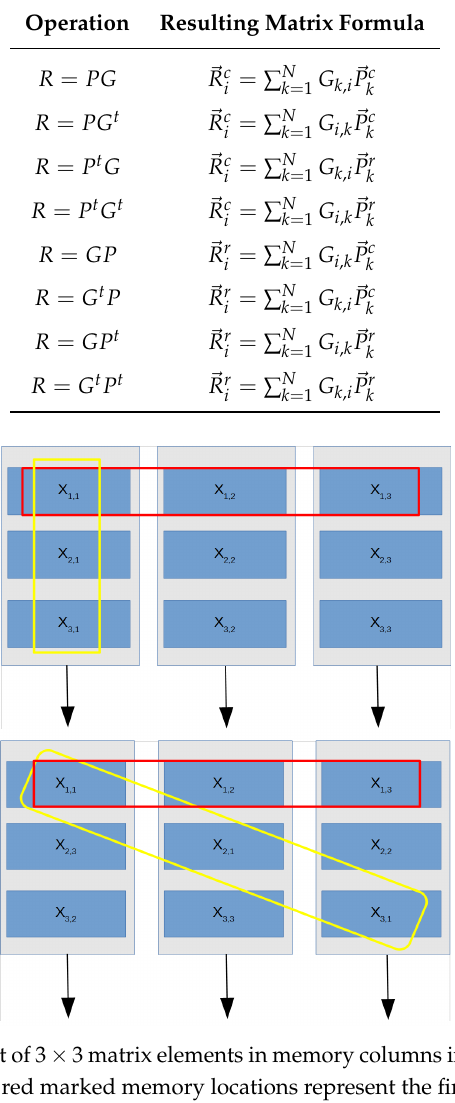
Table 1. Matrix-by-matrix multiplication possibilities using scalar-by-vector operations.